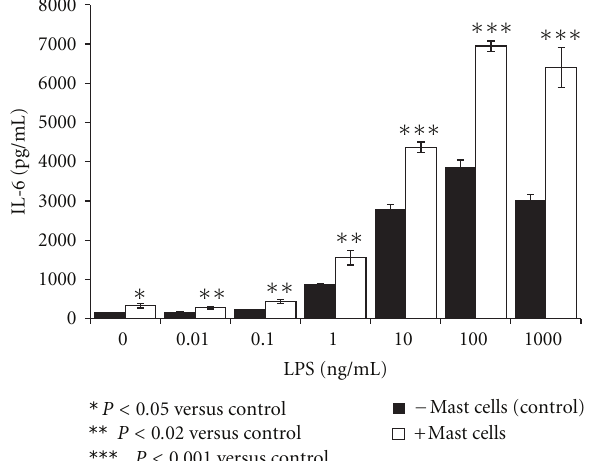
Figure 1: Mast cells potentiate LPS- induced IL-6 production by HCAEC. Endothelial cells (10,000cells/well) were grown for 24h in the presence or absence of HMC-1 5C6 (5000 cells/well) and stimulated with indicated concentrations of LPS. Following incubation, the cell culture supernatants were analyzed for IL-6 by ELISA. Results presented are mean ± SEM of quadruplicate determinations of a representative experiment. Similar results were observed in two additional experiments.